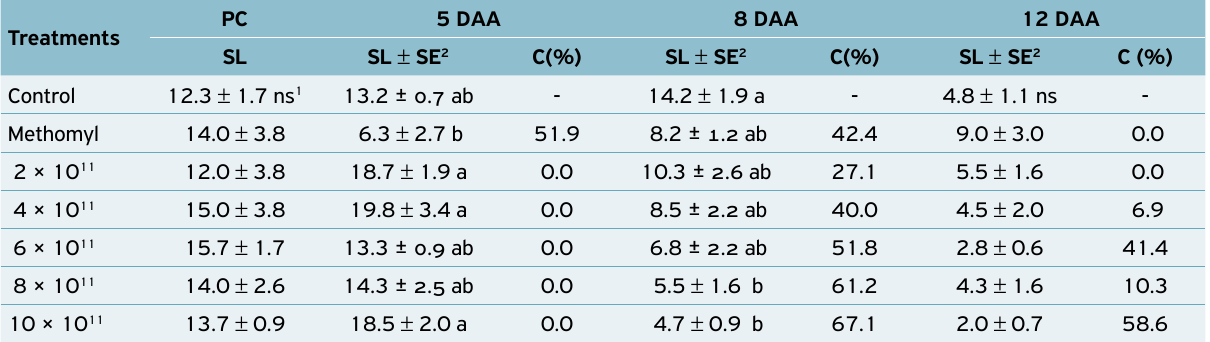
Table 1. Average number of small Chrysodeixis includens larvae (SL) and control percentage (C) obtained before (pre-counting – PC) and at 5, 8 and 12 days after application (DAA) of treatments in soybean plants in Caarapó, MS, Brazil.